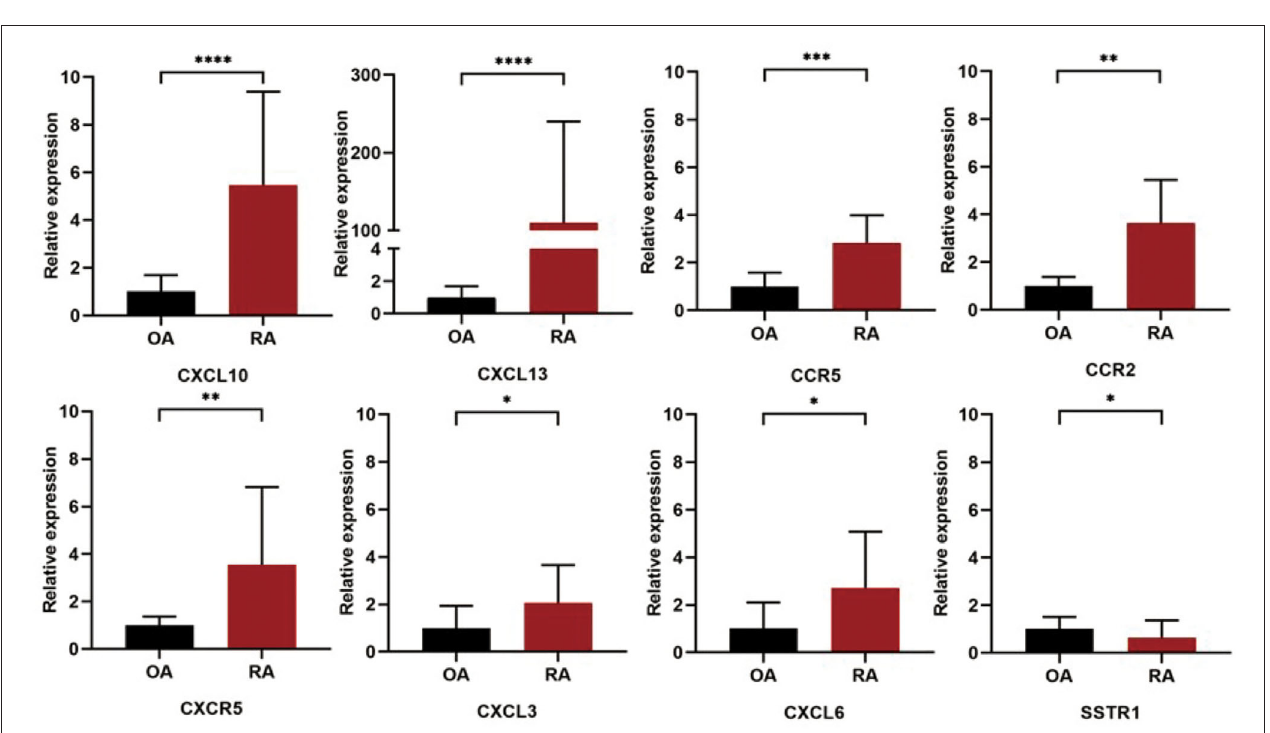
FIGURE 6 | Validation of the 10 hub DEGs identified in the synovial tissue samples of patients with RA and OA by quantitative real-time PCR (qRT-PCR). The relative expression levels of each gene were calculated using the 2 − 11 Ct method. ****, P < 0.0001, ***, P < 0.005, **, P < 0.01, *, P < 0.05.